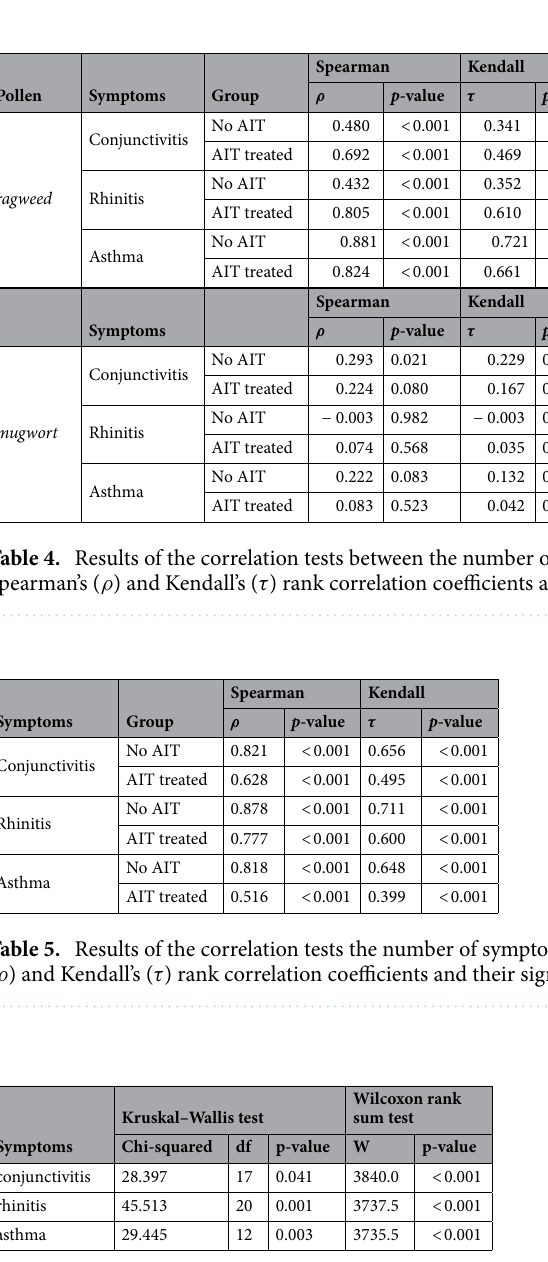
Table 6. Kruskal–Wallis test and Wilcoxon rank sum test results for comparing no AIT and AIT treated mean symptom levels (alternative =